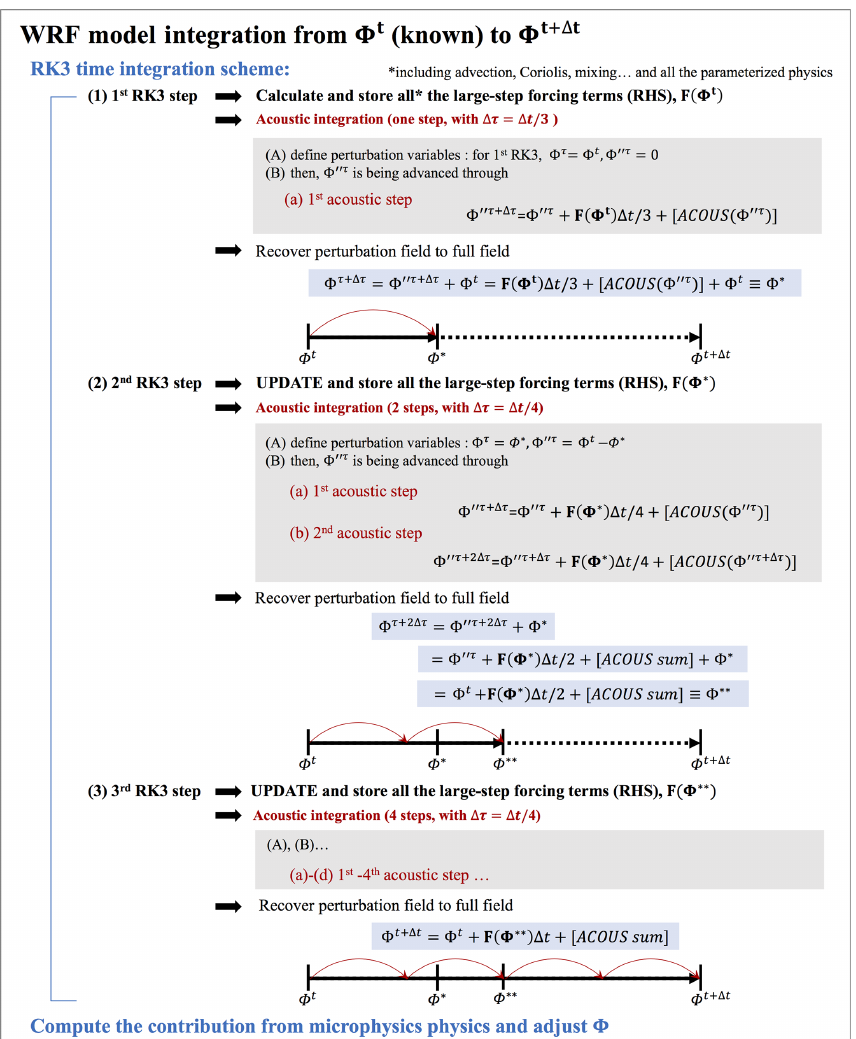
Figure 1. The time integration strategy for advancing a state variable (generalized as (cid:56) ) in the WRF model based on Skamarock et al. (2008). In this given example, four acoustic steps are specified for one integration